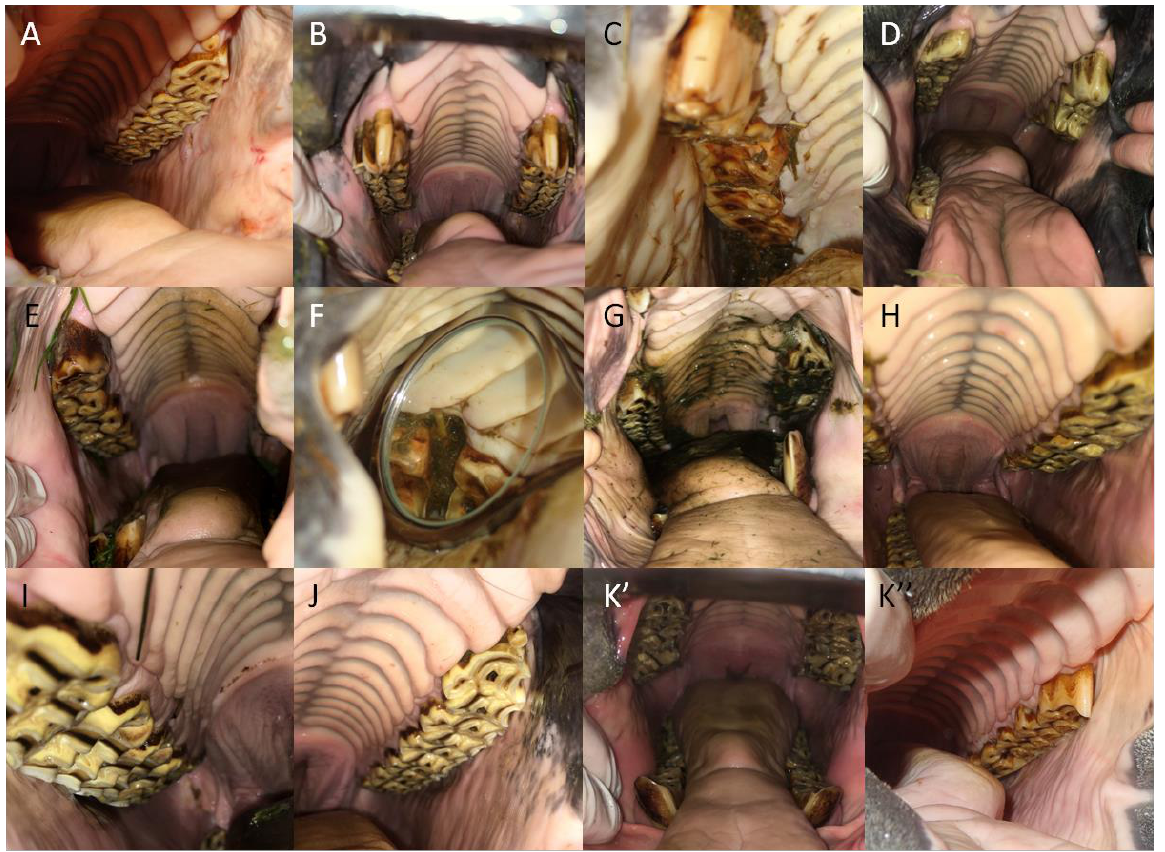
Figure 6. The samples of the malocclusions of the premolar and molar teeth in horses. Sharp enamel points ( A ); overgrown tooth ( B ); wave mouth ( C ); step mouth ( D ); displaced teeth ( E ); diastema ( F ); oligodontia ( G ); polydontia ( H ); retained deciduous teeth (RDT) ( I ); excessive transverse ridges (ETR) ( J ); and hooks ( K ’ , K ” ).